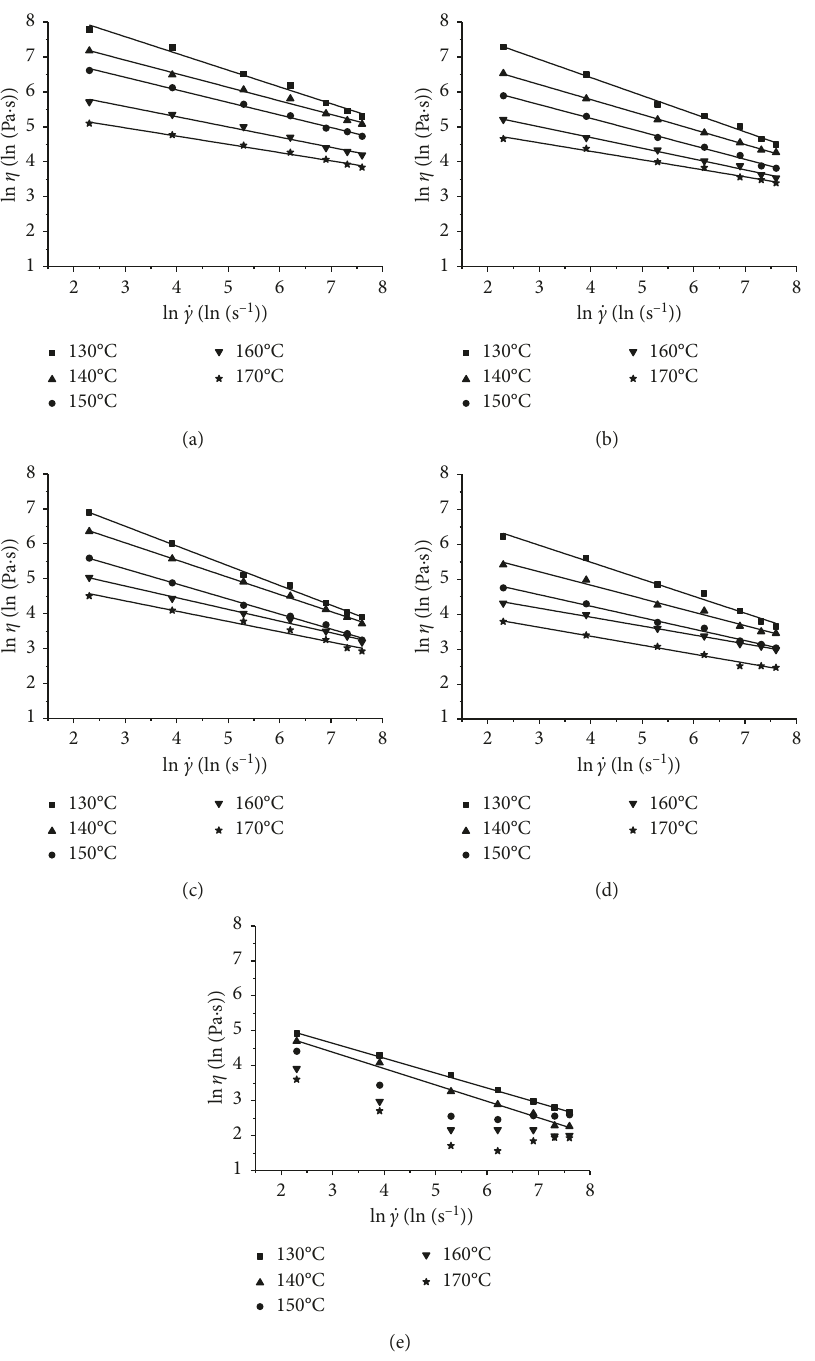
Figure 3: Shear rate dependence of the viscosity of the feedstock: (a) B13, (b) B15, (c) B17, (d) B19, and (e) B21 at different temperatures.